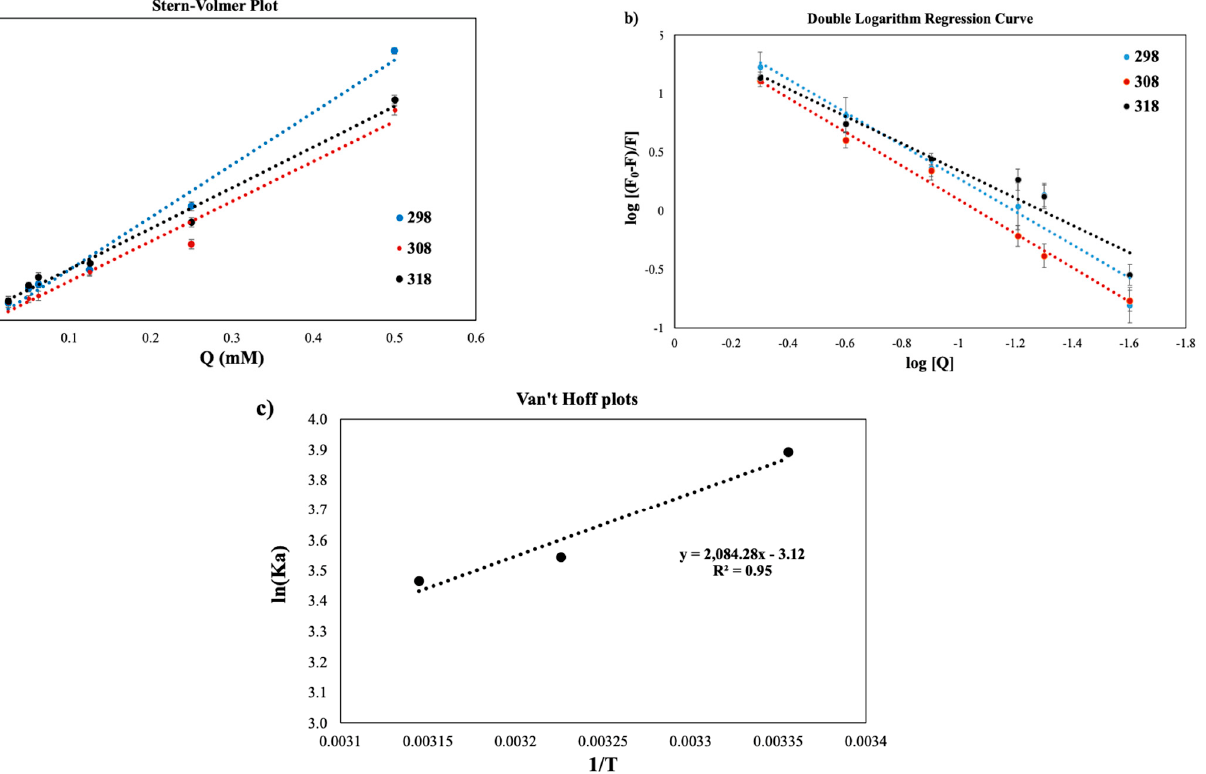
F 0 / Δ F was found linear to 1/[Q] so that the slope gave 1/(f a K a ), and from the intercept to ordinate, 1/f a was found. Then, the effective quenching constant for the accessible fluor- ophore ( K a ) was calculated as the ratio of 1/f a to 1/(f a K a ) . The linear lines intersected the y- axis at a value of around 1, meaning that all the fluorescence was due to quenchable Trp. These data, therefore, conform to the assumptions from the Stern–Volmer curves that all